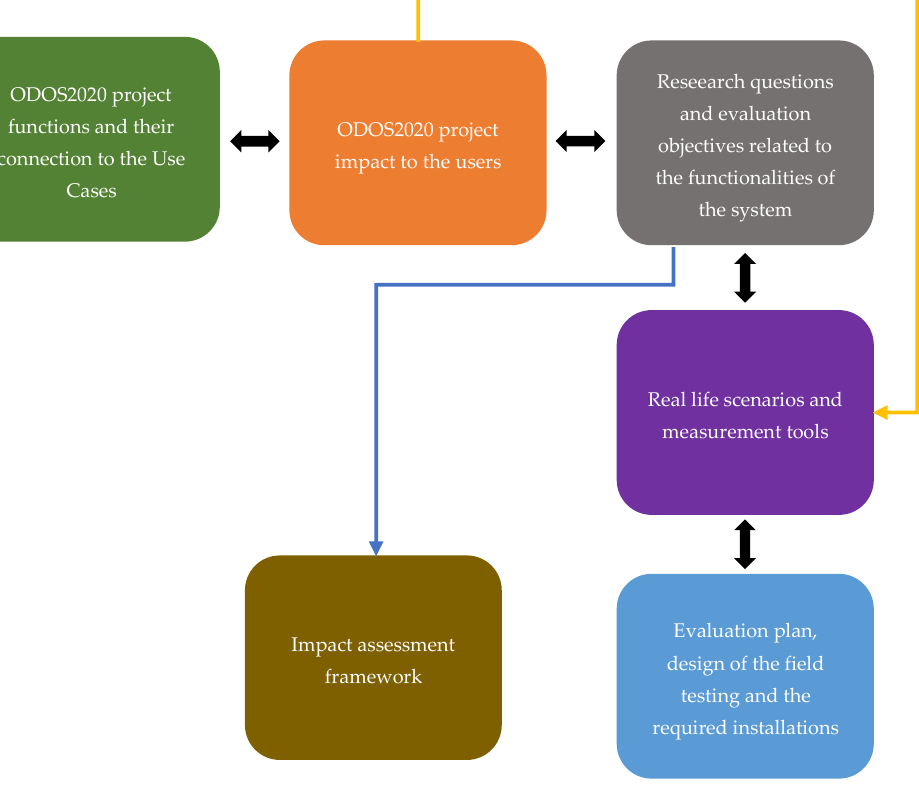
Figure 6. The ODOS2020 evaluation framework.